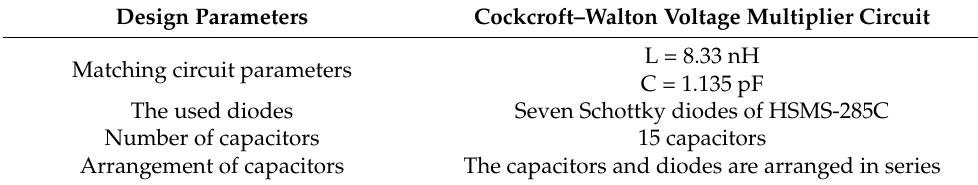
Table 1. Design parameters of the design for fr = 900